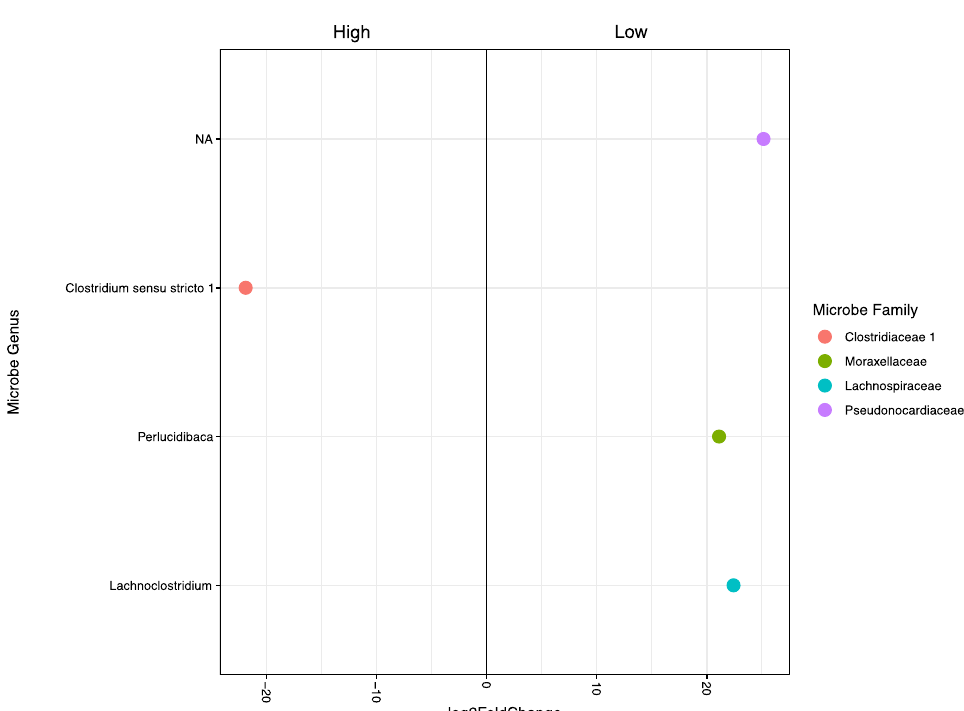
Fig. 6 Differential abundances between low and high elevational categories. ASV’s enriched in higher elevations fall to the left side of the x-axis, while those enriched in lower elevations fall to the